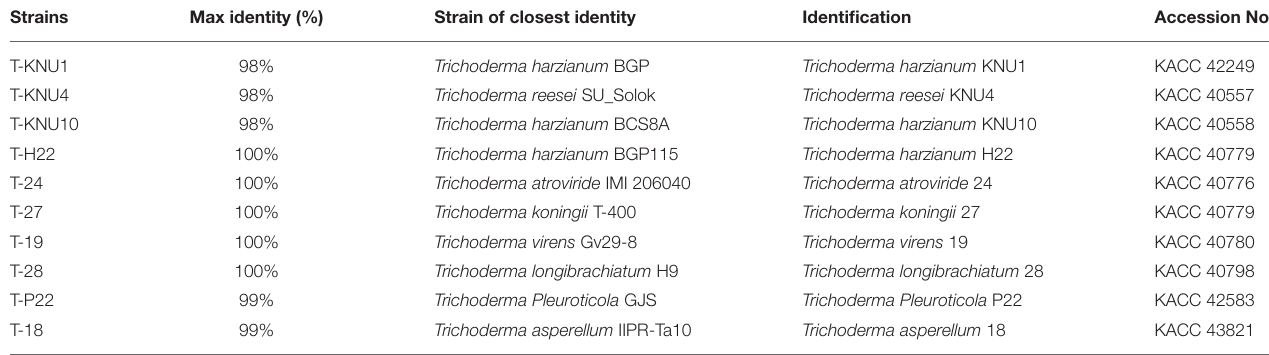
TABLE 1 | Trichoderma strains isolated from rhizosphere soils and their identification. Strains Max identity (%) Strain of closest identity Identification Accession